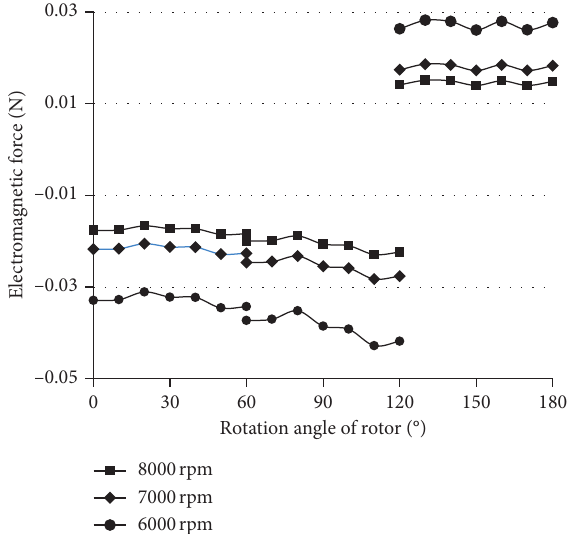
Figure 11: The electromagnetic force acting on the rotor in a circle at different rotating speeds.